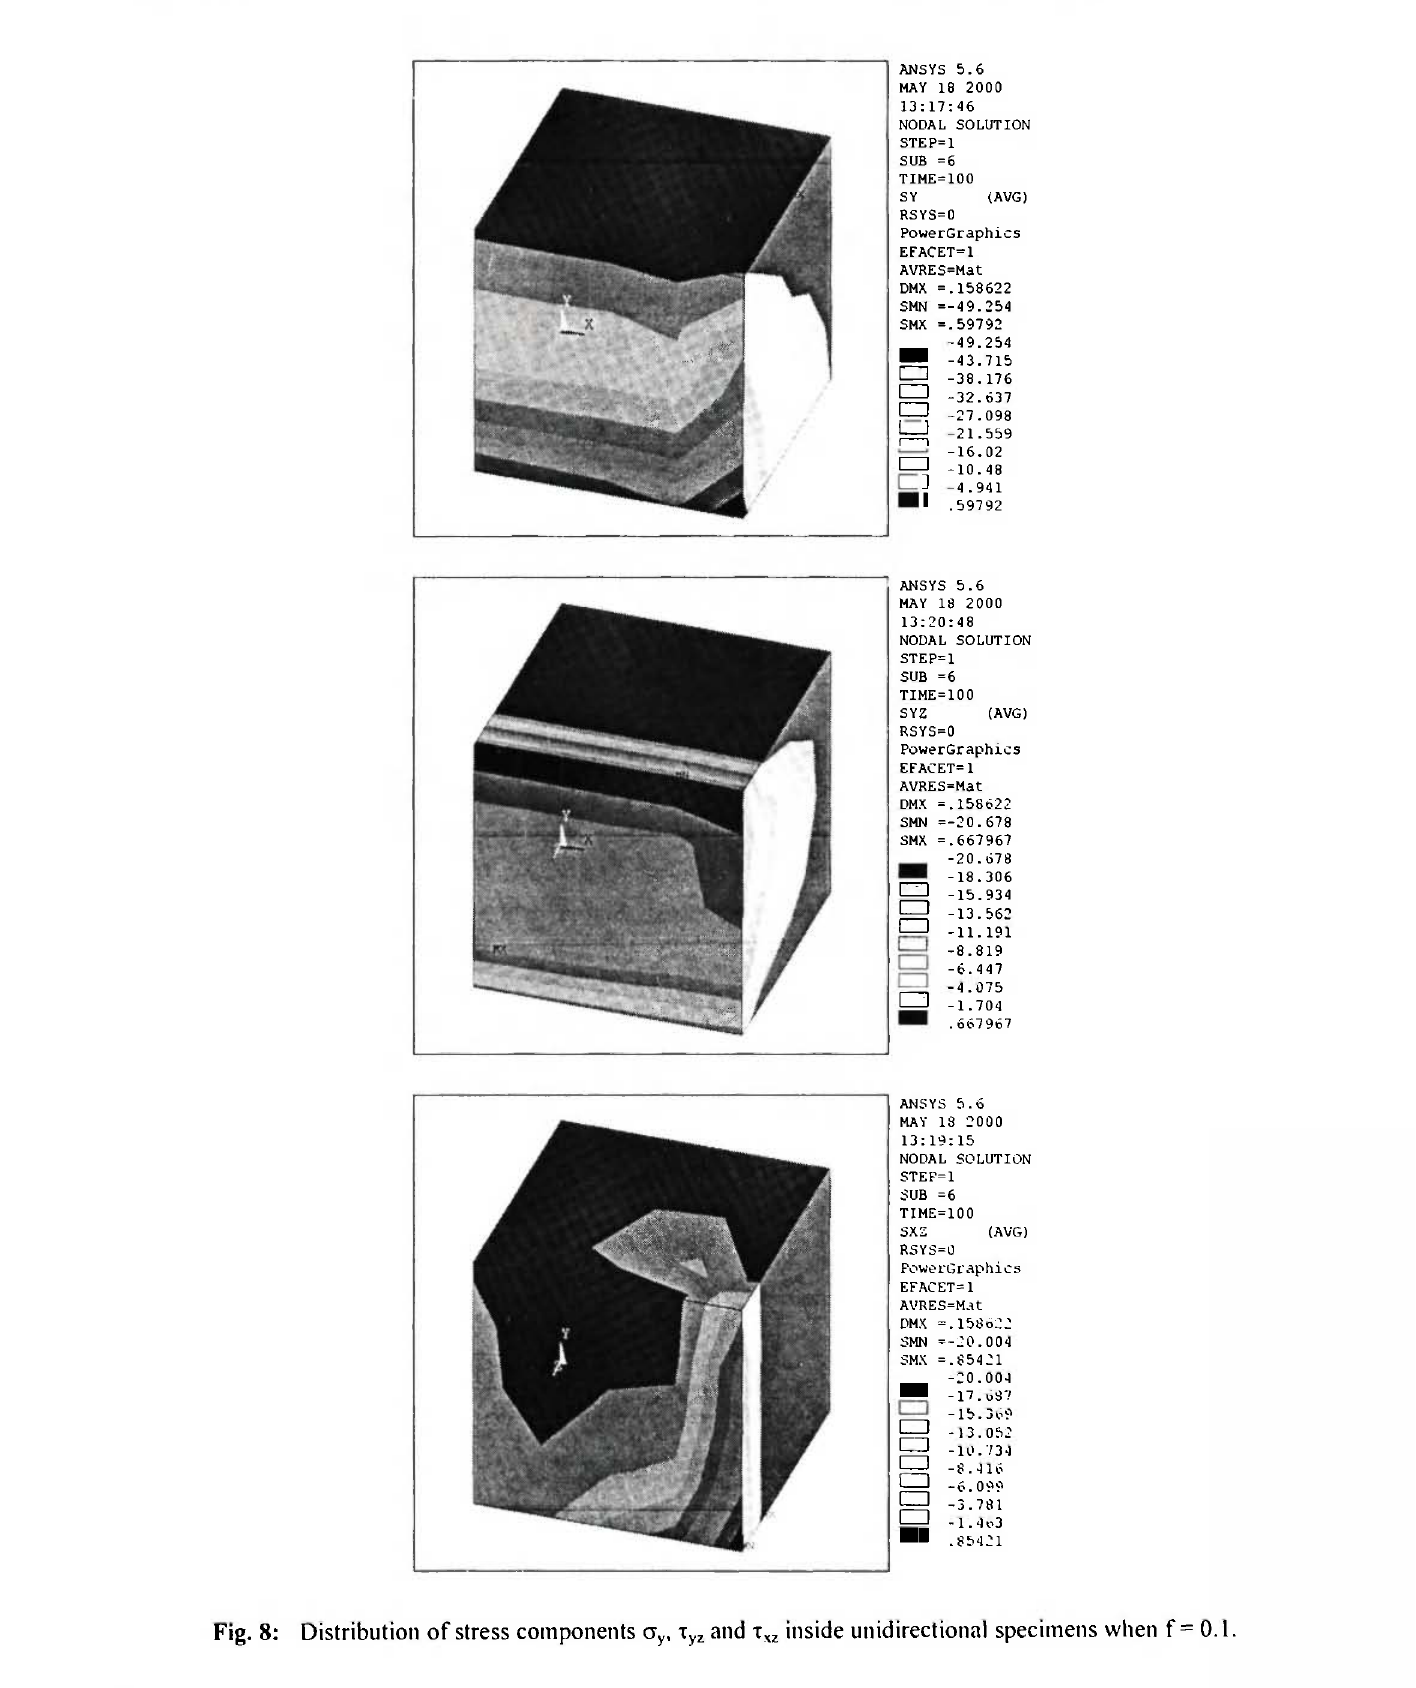
Fig. 8: Distribution of stress components a y , T yz and τ χζ inside unidirectional specimens when f =0.1.